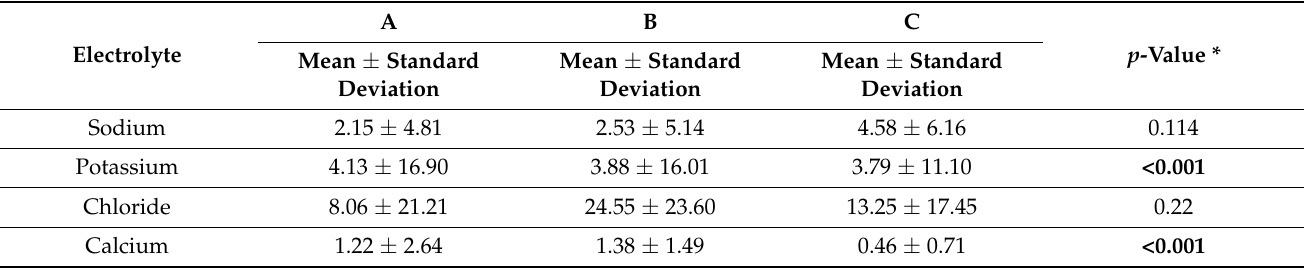
Table 5. Mean concentration of sodium, potassium, chloride, and calcium ions in the three groups.